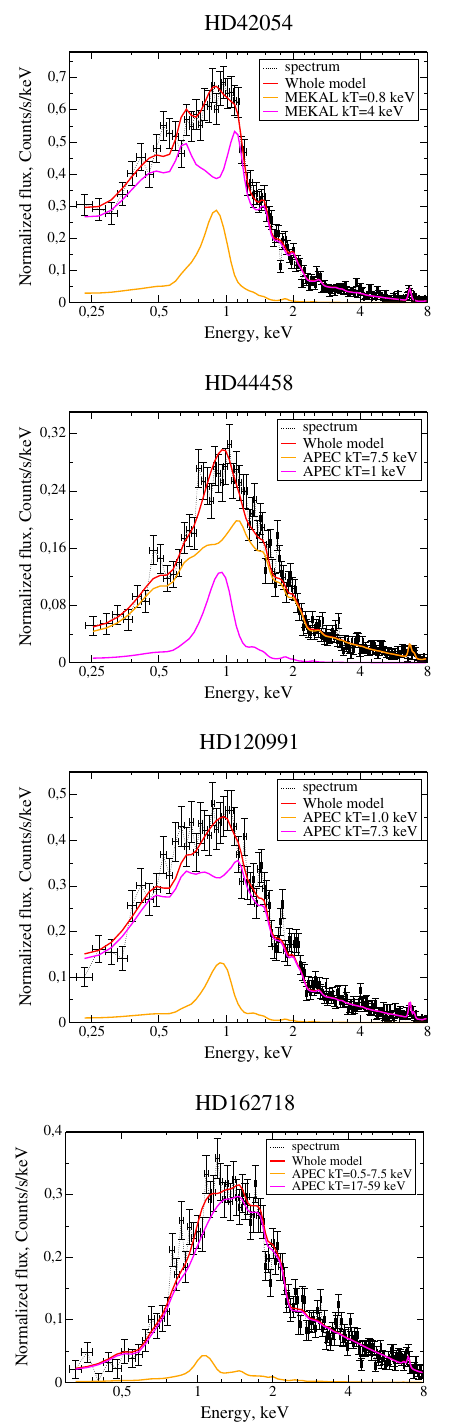
Figure 1. The best fits of stellar spectra by thermal models. The contributions of individual components into the total model X- ray spectra are shown by color lines. For the model spectrum of HD 162718 ( bottom panel ), confidence ranges of plasma tempera- ture are presented.